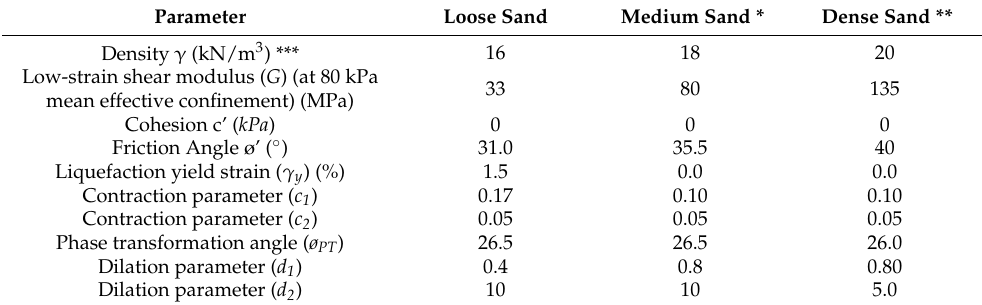
Table 6. Characteristics of the